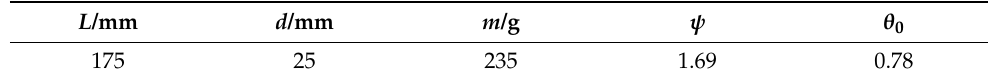
Table 2. Dimensions of the torpedo